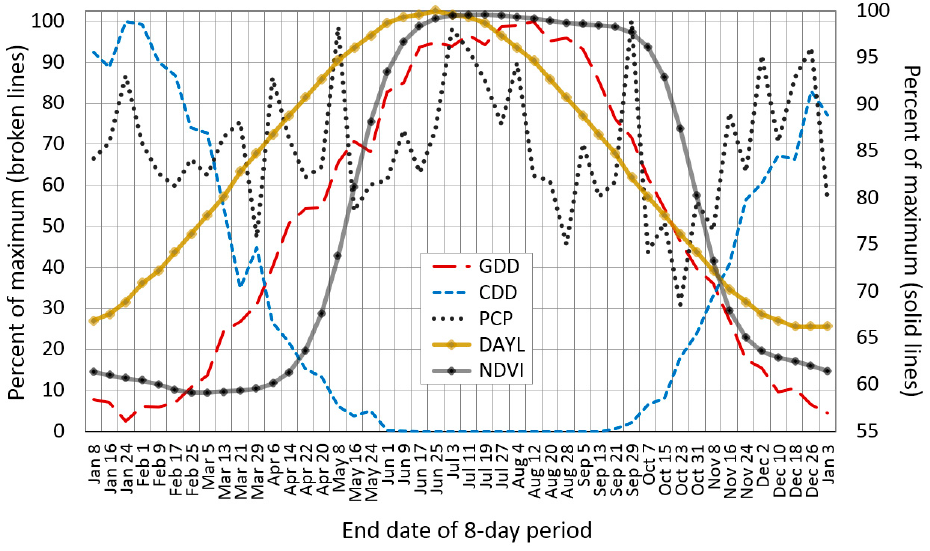
Figure 2. Variation in mean cumulative growing degree days (GDD), cumulative chilling degree days (CDD), precipitation (PCP), daylength (DAYL), and NDVI for all vegetation types expressed as Percent Completion—the percentage of the respective maximum 8-day period values, 2000–2015, for Great Smoky Mountains National Park.